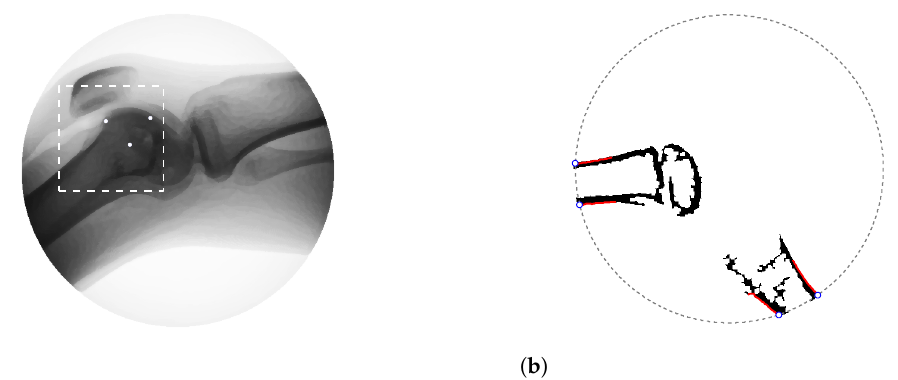
and p a (round marker), and set of points p p 1 1